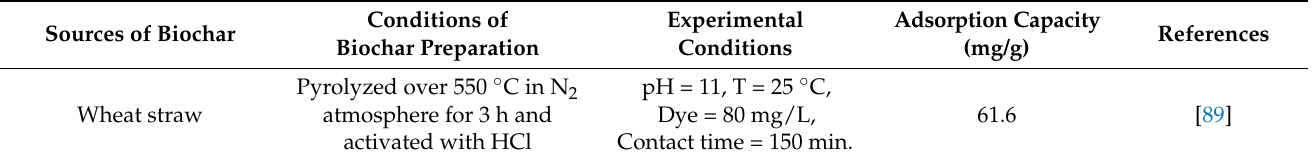
Figure 6. Langmuir ( A ) and Freundlich ( B ) linear data fit for MB removal on BGS-derived biochar. The MB sorption results of different biochar prepared from diverse sources are pre- sented in Table 2. Table 2. Methylene blue (MB) sorption results of biochar derived from different